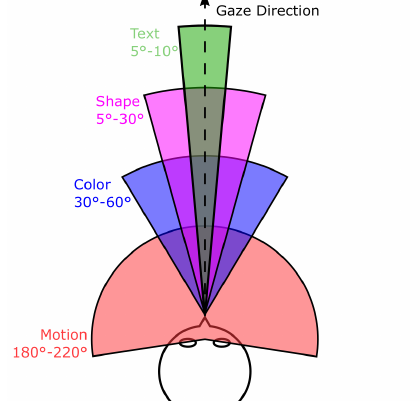
Figure 2: Schematic representation of the horizontal field of view. Movements are almost perceptible over the entire field of vision, while colors are mostly perceived, and can only be identified in the inner ±30°. Detailed perceptions such as shapes or texts, which depend on a very high resolution and sharp contrasts, are therefore only available in the middle of the field of view. (Strasburger et al. 2011; Pelli et al. 2017; Abramov et al. 1991, 1991; To et al.